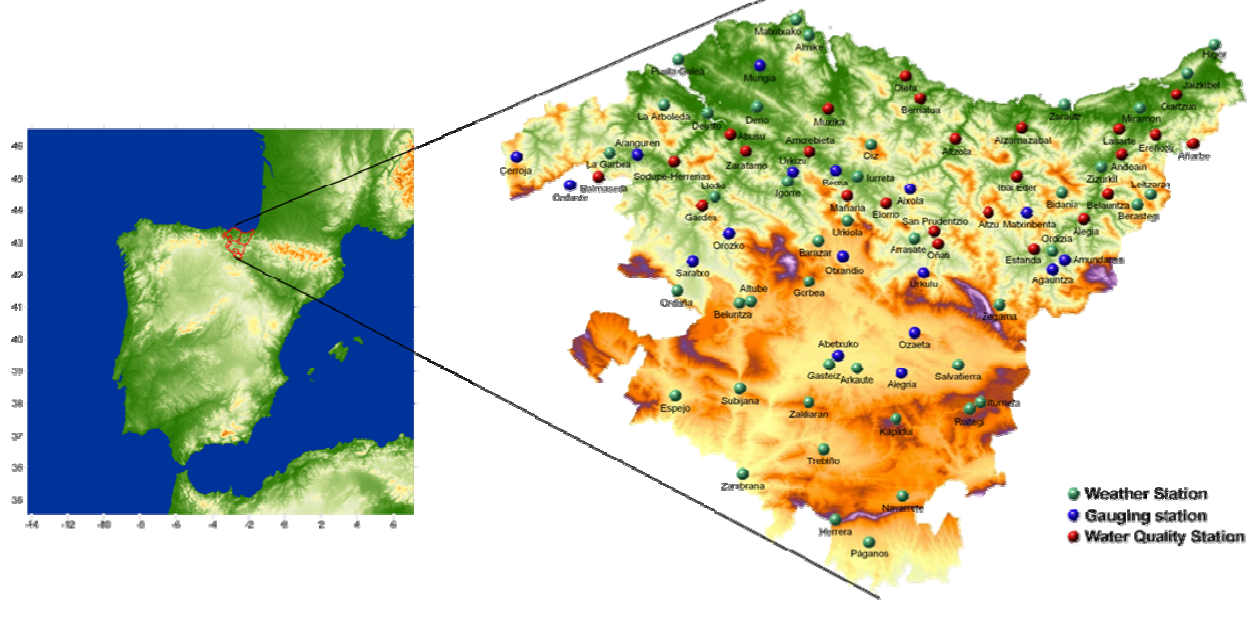
Figure 2. Basque Country location and Mesonet